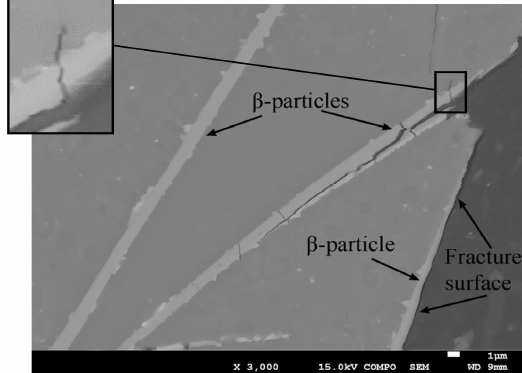
Figure 11. SEM image towards the fracture surface of Alloy B SDAS 25 showing a secondary crack propagating within the β‐ particle and a β‐ particle along the fracture surface.